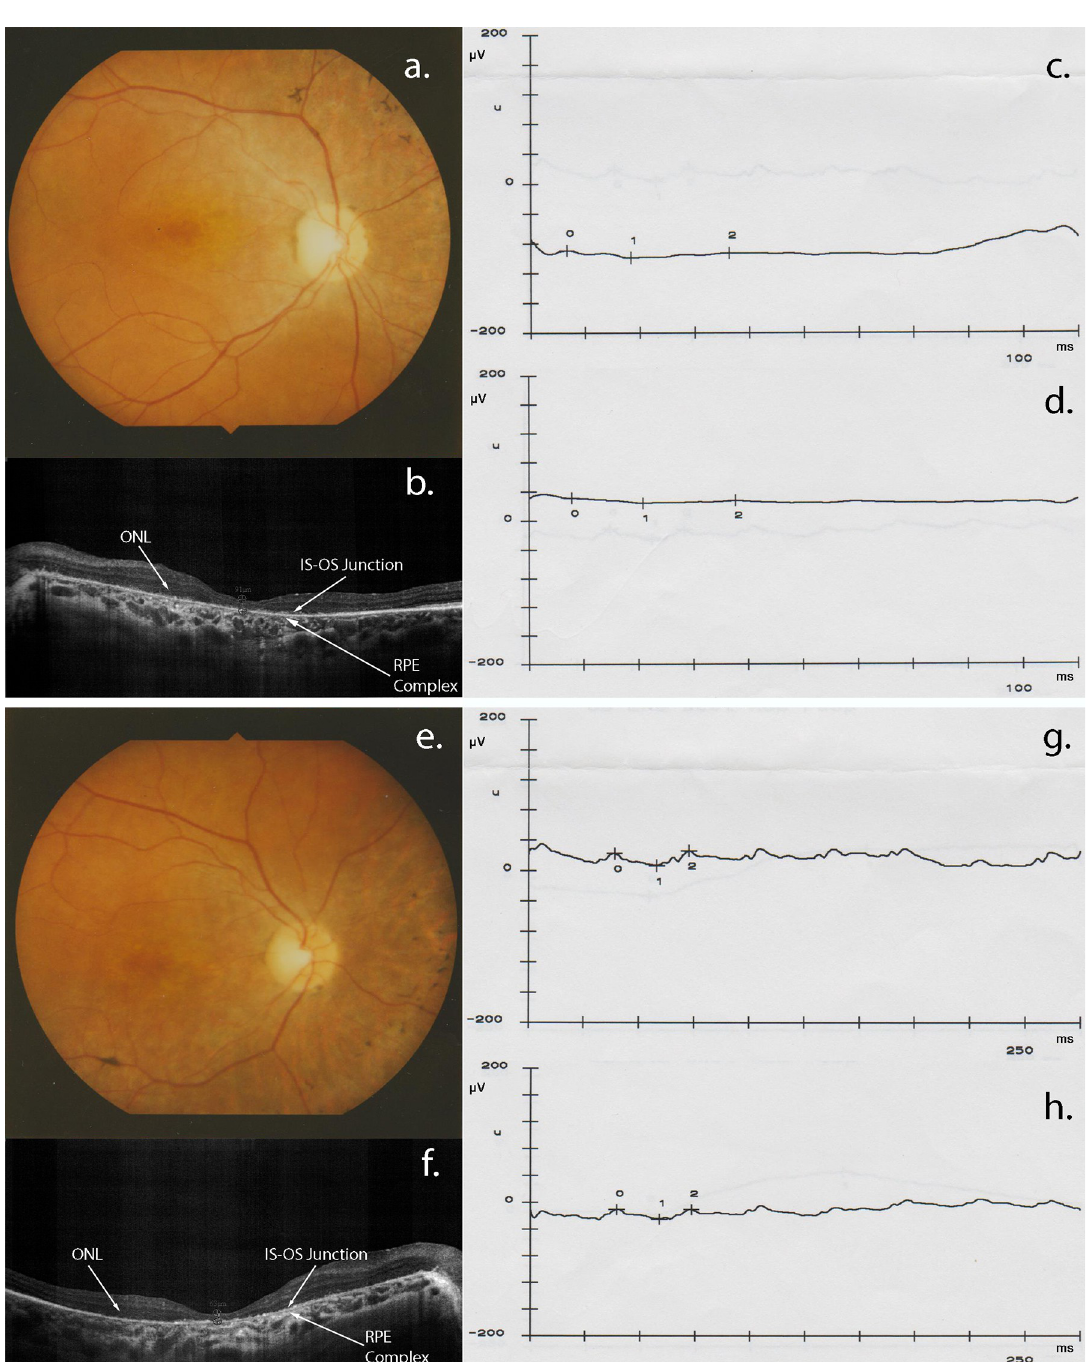
Fig 2. Proband’s fundus, optical coherence tomography (OCT) and electroretinogram (ERG). Fundus photo of left eye is shown upside down. Fundus examination demonstrated mild changes typical of RP in the left (a) and the right (e) eyes, including slightly pale optic discs with almost normal retinal vessels, generalized pigmentary granularity, and moderate bone-like spicules in peripheral areas. The OCT scans of the left eye (b) and the right eye (f) revealed decreased macular thickness, as well as a severe loss of EZ line and outer segments. Scotopic (c, g) and photopic (d, h) ERGs revealed a generalized cone dysfunction with rod involvement. ONL = Outer Nuclear Layer. IS-OS Junction = Inner Segment-Outer Segment Junction. RPE Complex = Retinal Pigment Epithelium